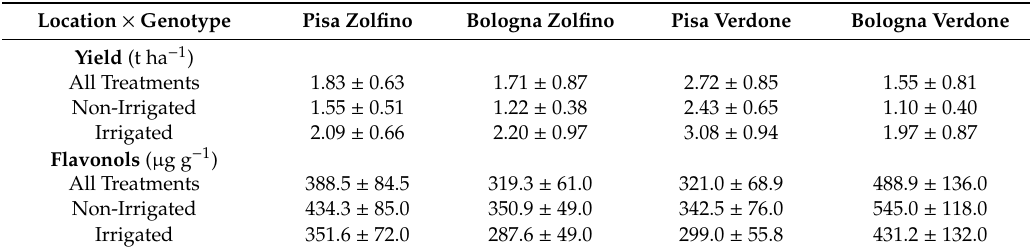
Table 2. The interaction Location × Genotype on yield and flavonol content. Values are the means ± SD. The interaction Location × Genotype is significant at p < 0.05 for yield and flavonol content. For all treatments n = 24, for non-irrigated n = 12, and for irrigated n = 12. Location × Genotype Pisa